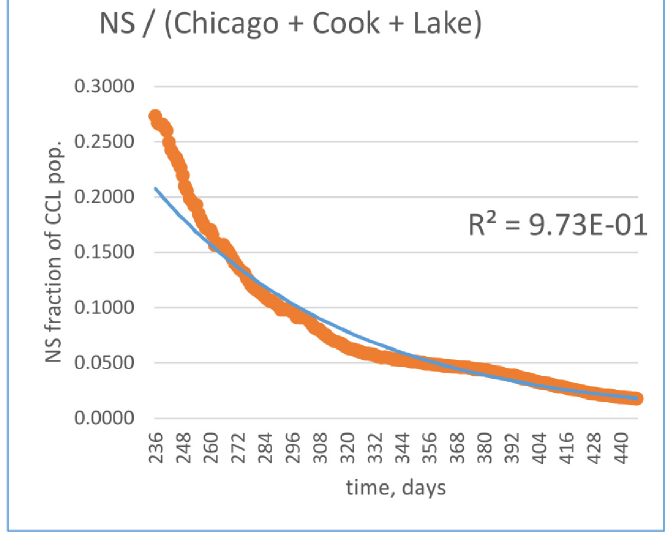
Fig 1. The ratio of NS and CCL populations. x-axis : elapsed time in days since March 10, 2020 (first identified NS case); y-axis : NS / CCL population ratio less 0.452 (asymptotic limit).